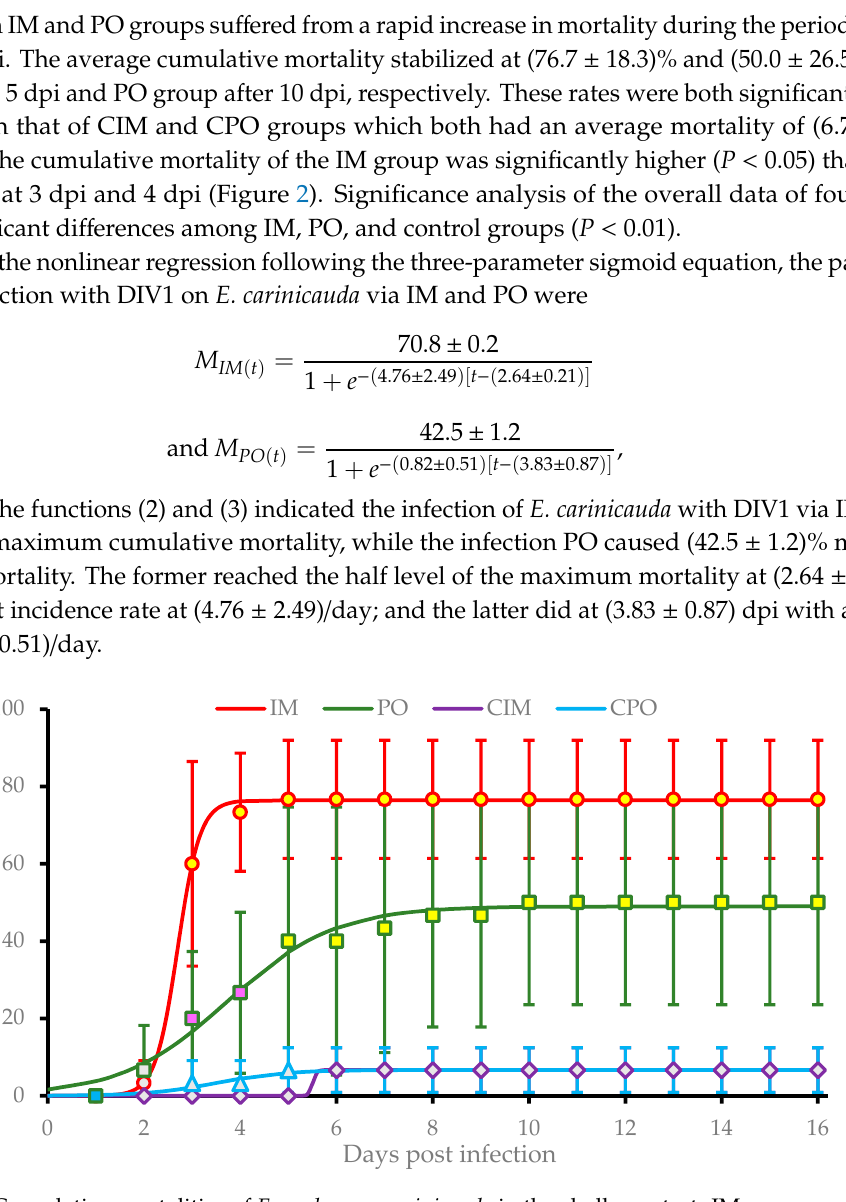
Figure 2. Cumulative mortalities of Exopalaemon carinicauda in the challenge test. IM group, prawns were challenged with filtrated viral suspension via intermuscular injection; PO group, prawns were fed with tissues of DIV1-infected P. vannamei ; CIM group, prawns were injected with sterile PPB-His buffer; CPO group, prawns were fed with commercial feed. Cumulative mortalities are shown as means of data from three replicates for each experimental group (each replicate contained 10 individuals). The mean points with same color indicate no significant difference ( P > 0.05), and the mean points with different colors indicate a significant difference ( P < 0.05). Overall analysis indicated there are very significant differences among IM, PO, and the two controls ( P < 0.01). The curves were drawn based on the nonlinear regression following the three-parameter sigmoid equation.